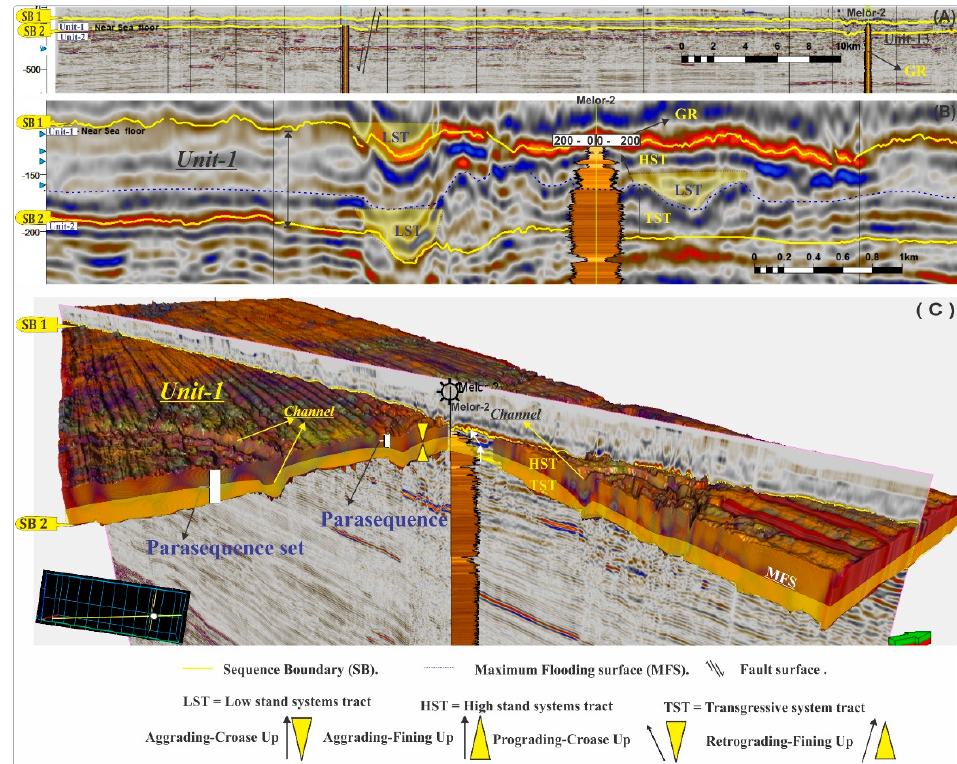
Figure 14. ( A ) A regional seismic cross-section of unit 1. ( B ) A detailed explanation of the sequence boundaries of unit 1 and its systems tract. ( C ) The 3D visualization of unit 1 with systems tract, channel, parasequences, and parasequence set.